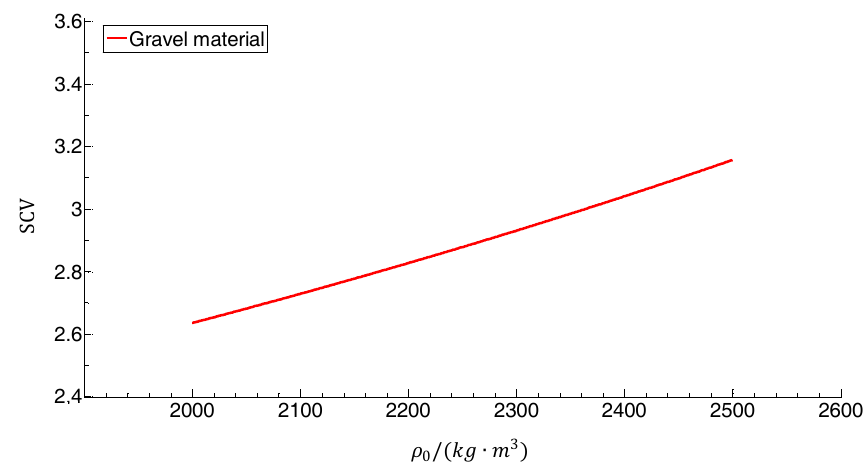
Figure 8. Relation curve between dry density of gravel materials and SCV based on A-model. SCV: sound compaction value.